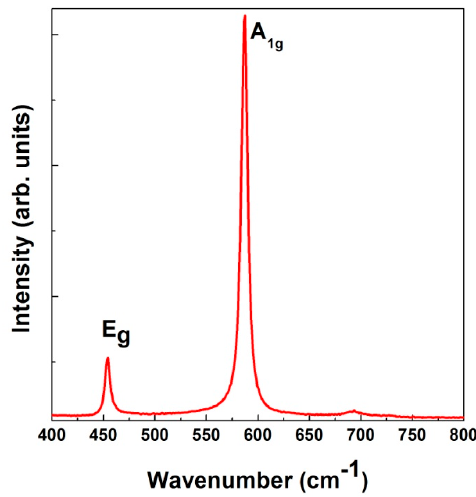
Figure 3. Raman spectrum of as synthesized LiCrO 2 at ambient pressure and temperature conditions. The two Raman active modes are clearly